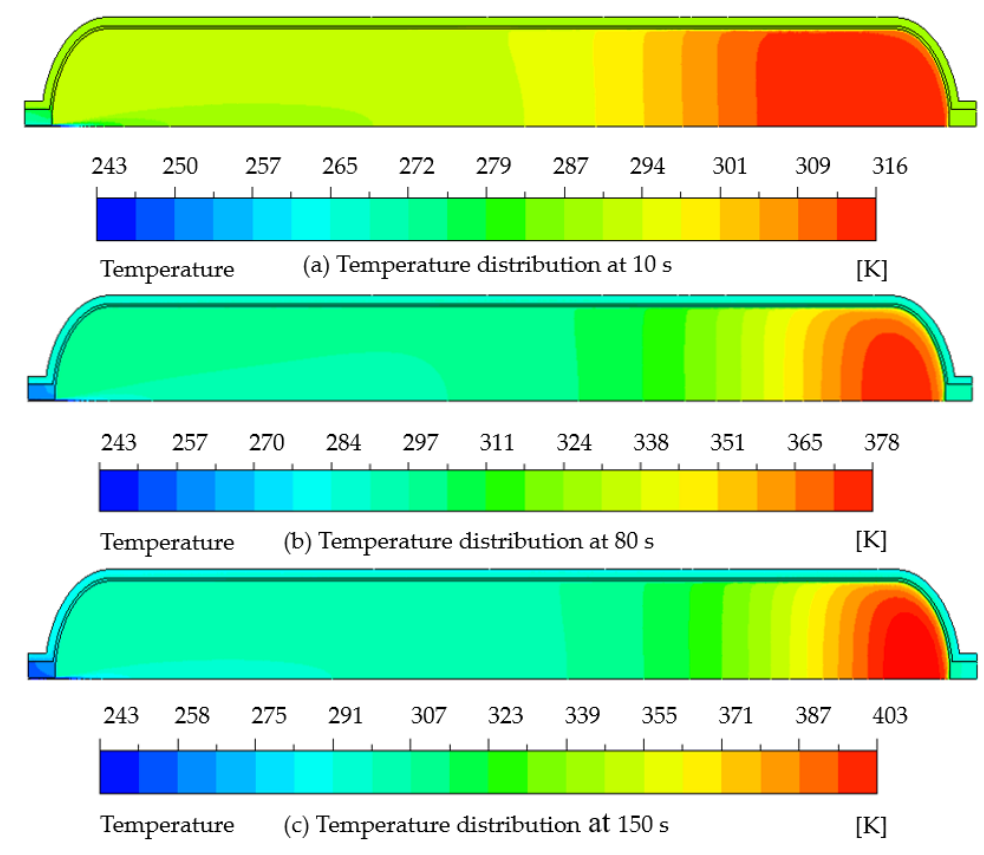
Figure 5. Temperature distribution at 10 s, 80 s, and 150 s.